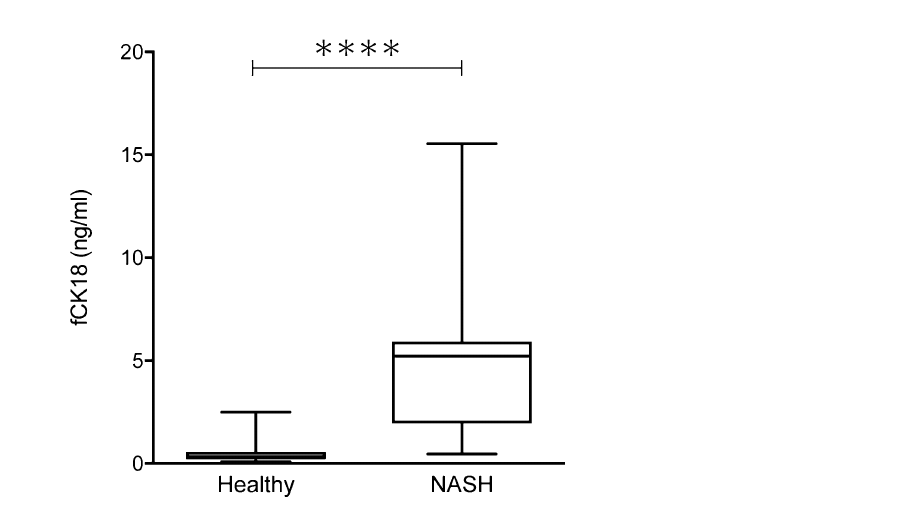
Figure 5. Distribution of serum fCK18 levels in healthy individuals and NASH patients. The measurement of serum fCK18 in 100 healthy individuals and 11 NASH patients using our highly sensitive CLEIA. NASH nonalcoholic